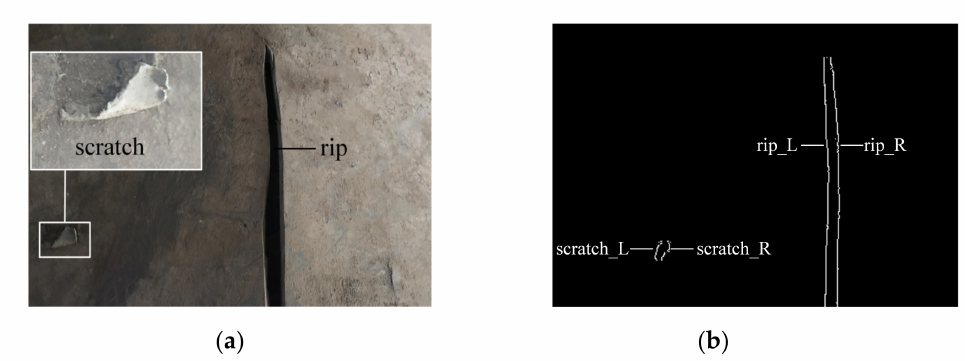
Figure 4. The result of suspected point extraction process. ( a ) The physical picture, the upper illustration is the zoom view of the lower rectangle box. ( b ) The in-situ result image of ( a